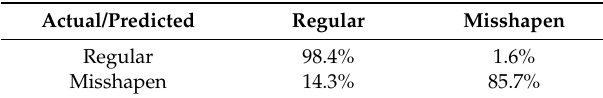
Table 6. Classification accuracy of the shape detection algorithm in on-line operation for sorting shape in testing set.